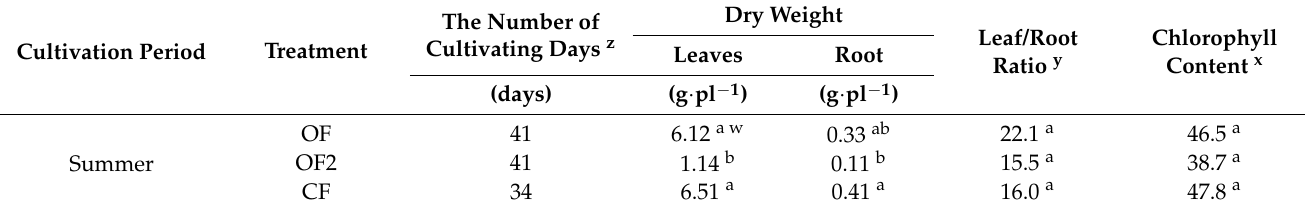
Table 2. The effect of different fertilization methods on the growth and yield of bok choy. Cultivation period